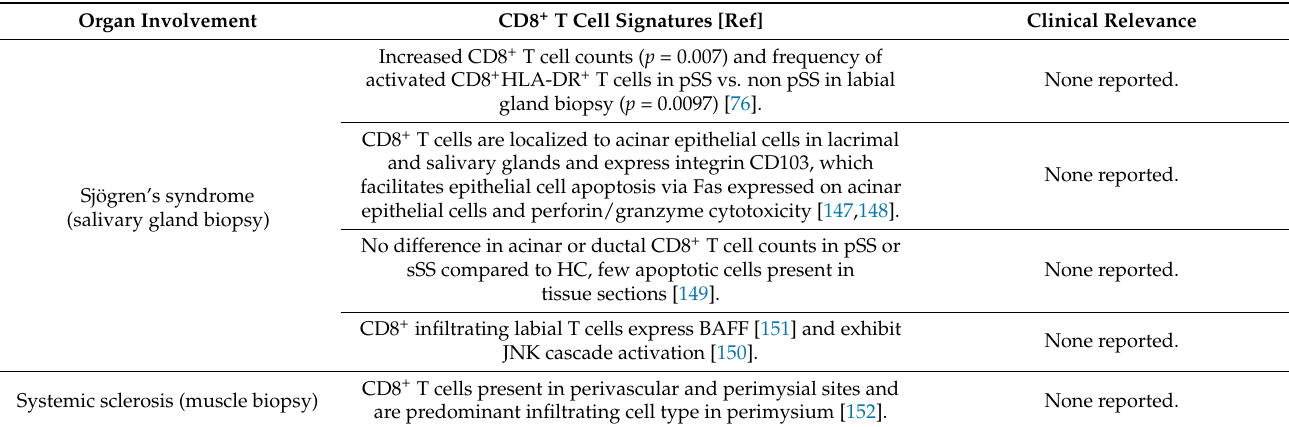
Table 7. Organ-specific CD8 + T cell profiles in other